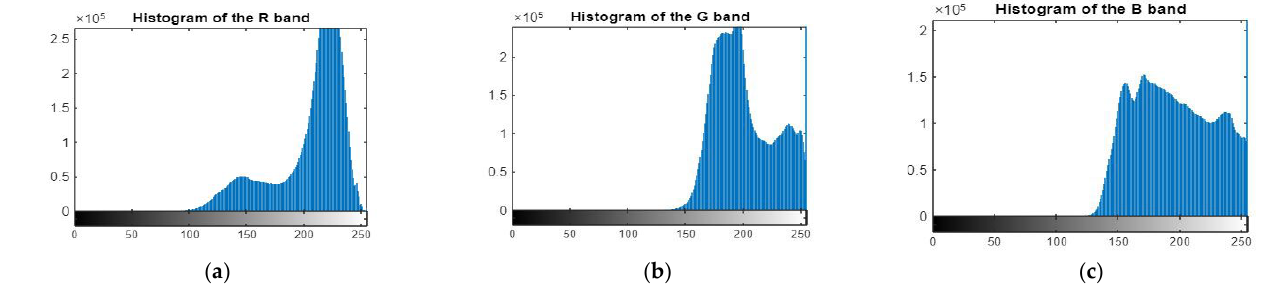
Figure 5. Histogram of R, G, and B bands of original image. ( a ) the R band, ( b ) the G band, ( c ) the B band.